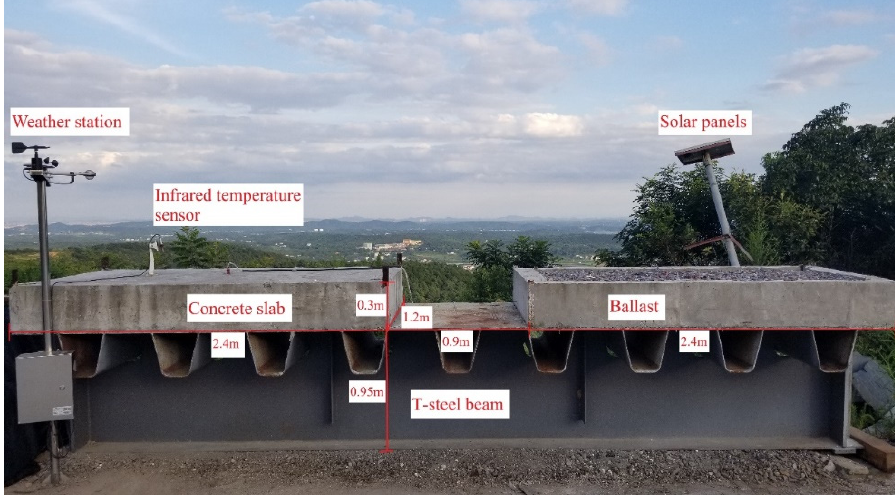
Figure 2. Temperature test of track structures on a T-steel beam segment.